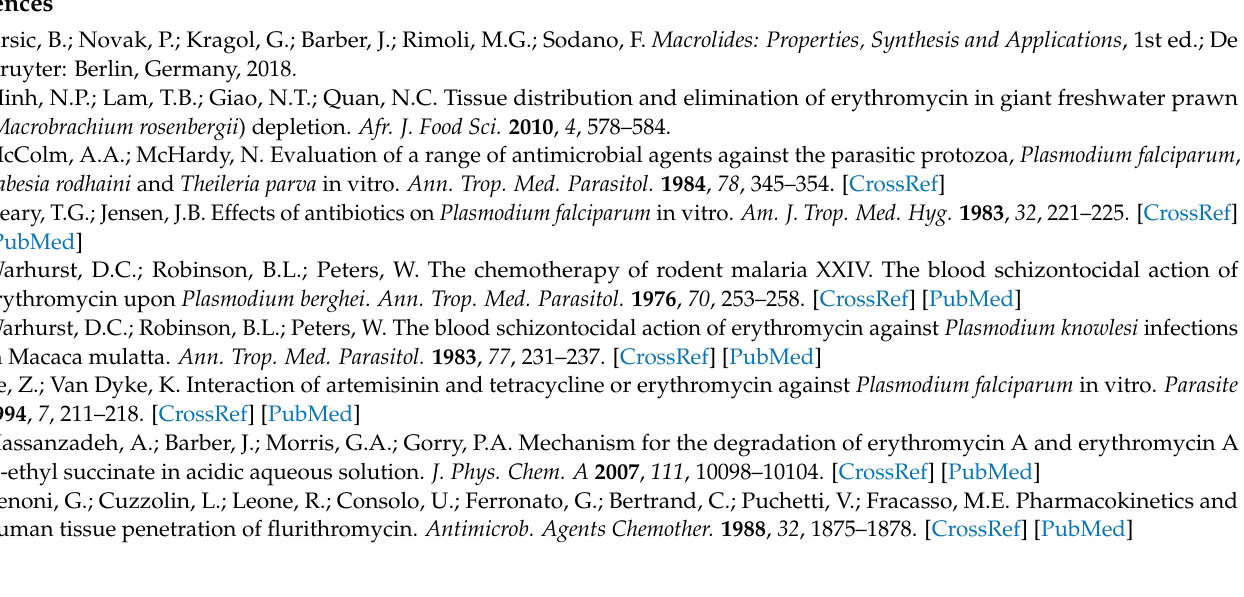
ribosome. Figure S18: Interactions between ( 5 ) (red) and the nucleotides from the binding site from E. coli ribosome. Figure S19: Interactions between ( 6 ) (red) and the nucleotides from the binding site from E. coli ribosome. Figure S20: Interactions between ( 2 ) (red) and the nucleotides from the binding site from E. coli ribosome. Figure S21: Interactions between ( 4 ) (red) and the nucleotides from the binding site from E. coli ribosome. Figure S22: Interactions between ( 1 ) (red) and the nucleotides from the binding site from E. coli ribosome. Figure S23: Interactions between rosaramicin (red) and the nucleotides from the binding site from E. coli ribosome. Figure S24: Interactions between ( 8 ) (red) and the nucleotides from the binding site from E. coli ribosome. Figure S25: Interactions between ( 7 ) (red) and the nucleotides from the binding site from E. coli ribosome. Figure S26: Interactions between erythromycin A (red) and the nucleotides from the binding site from E. coli ribosome. Figure S27: Interactions between erythromycin B (red) and the nucleotides from the binding site from E. coli ribosome. Figure S28: Interactions between erythromycin C (red) and the nucleotides from the binding site from E. coli ribosome. Figure S29: Interactions between tylosin A (red) and the nucleotides from the binding site from E. coli ribosome. Figure S30: Interactions between tylosin B (red) and the nucleotides from the binding site from E. coli